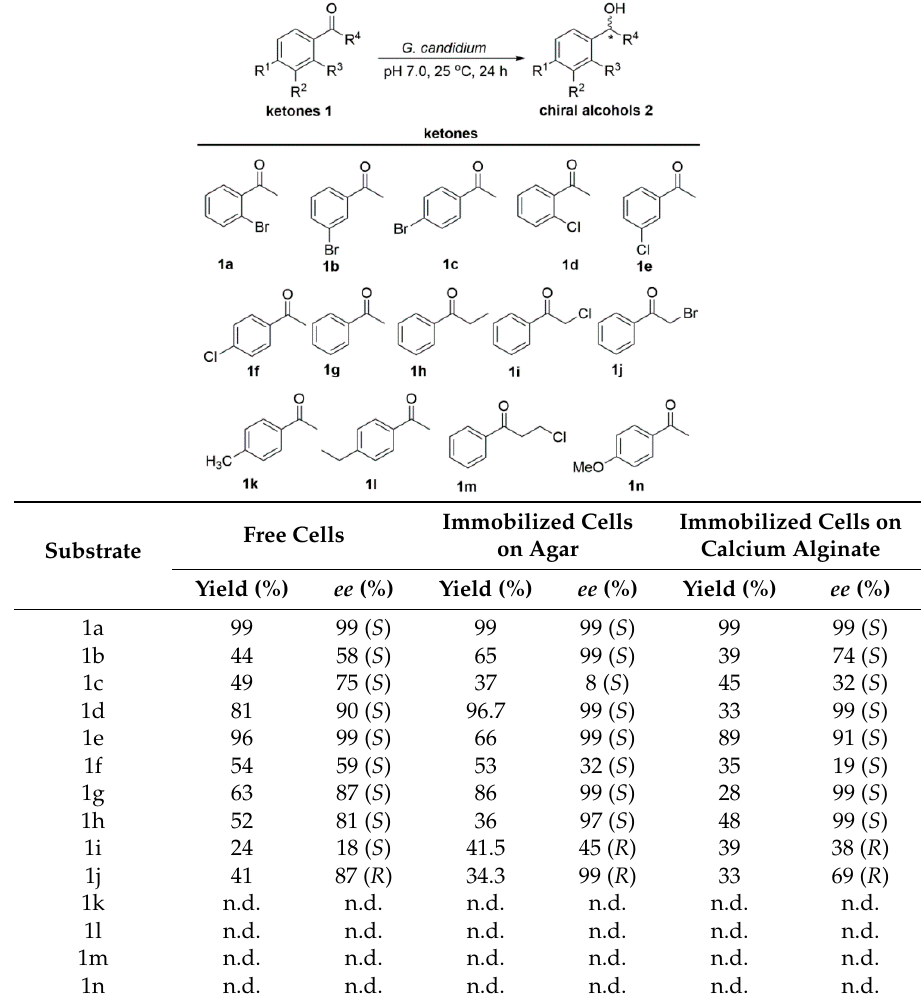
Table 1. Comparison of biocatalytic activity of free and immobilized cells for asymmetric reduction of various aromatic ketones a .